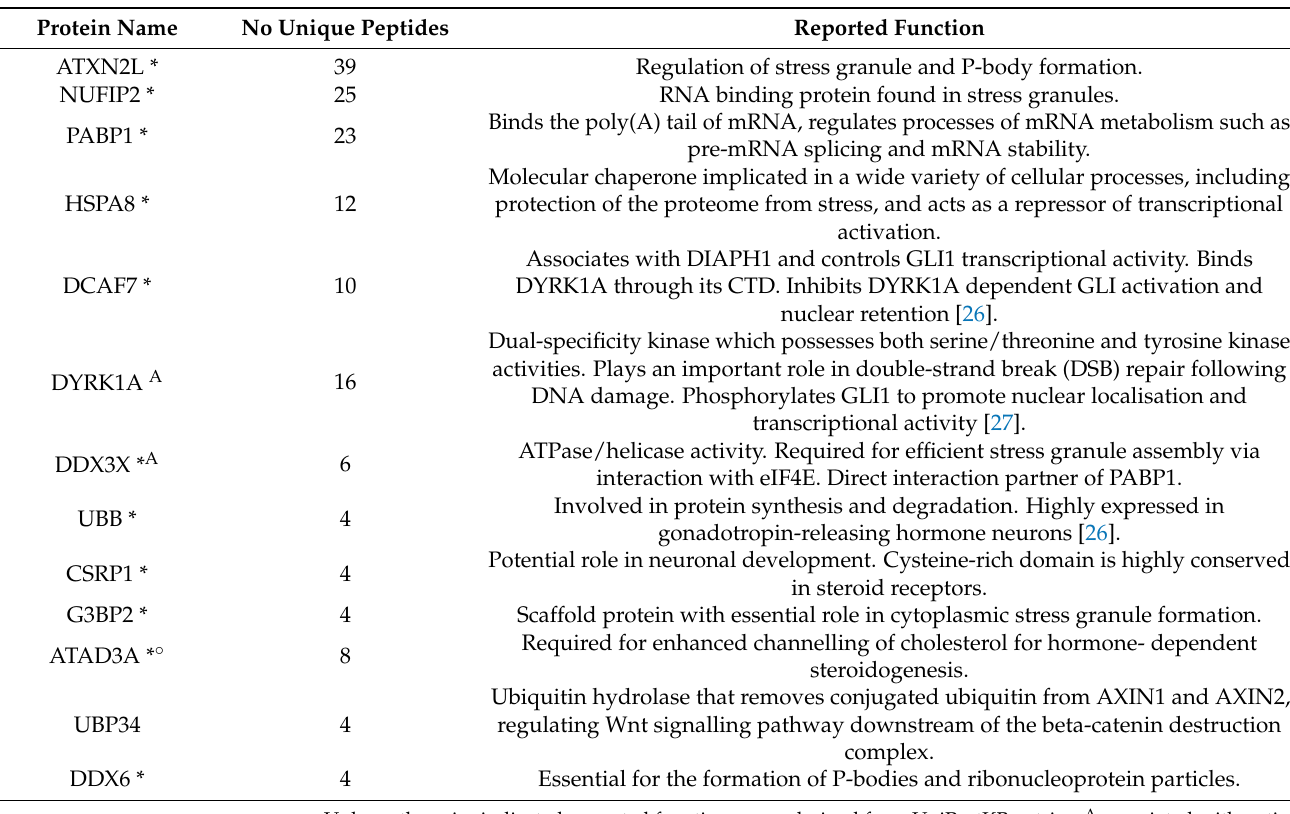
Table 1. PTCHD1-specific